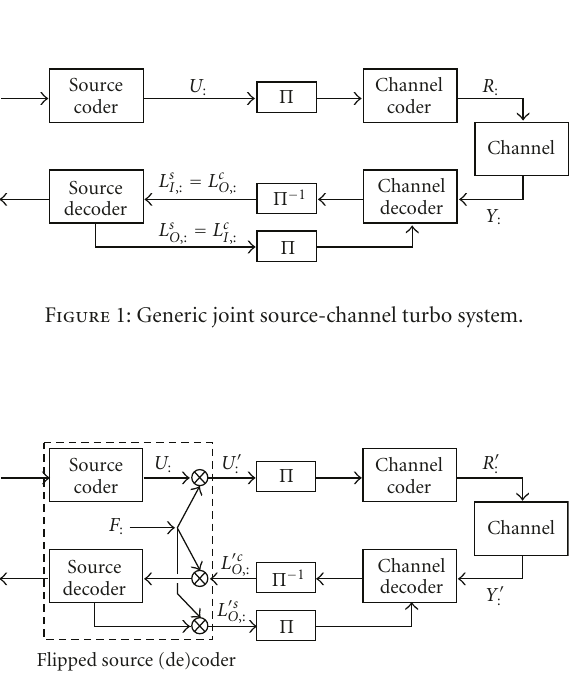
Figure 2: Equivalent system with a random bit